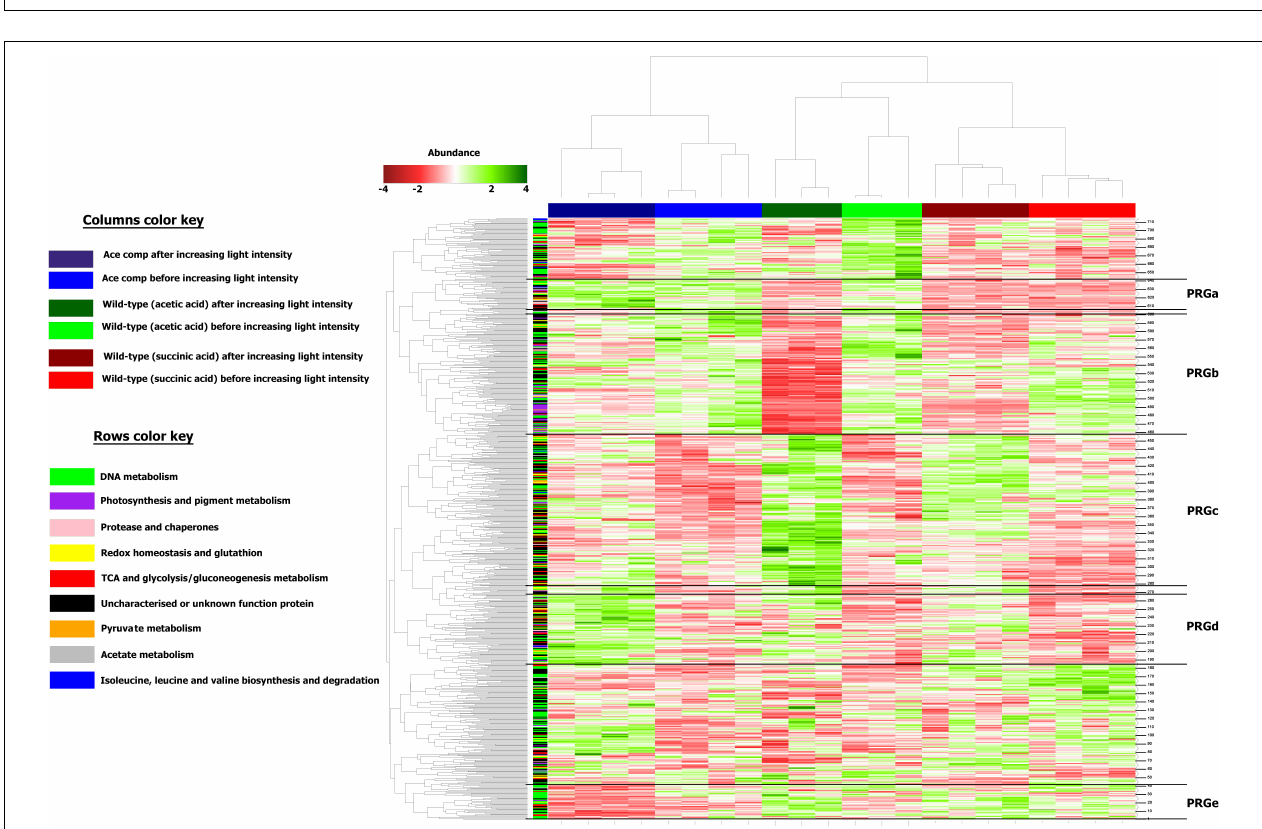
FIGURE 4 | Heatmap representation of the differentially abundant proteins considered in this study. Columns were separated by using forced Euclidean Hierarchical Clustering based on the growth conditions. Rows were separated by unforced Euclidian hierarchical clustering. Protein response groups (PRGs) were established based on color pattern and supported by Monte-Carlo